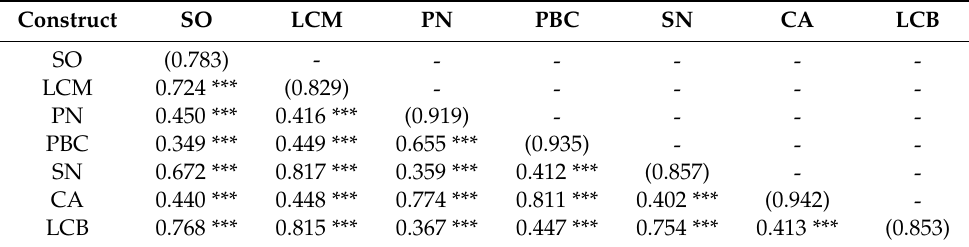
Table 9. Correlation matrix and discriminant validity for the constructs.